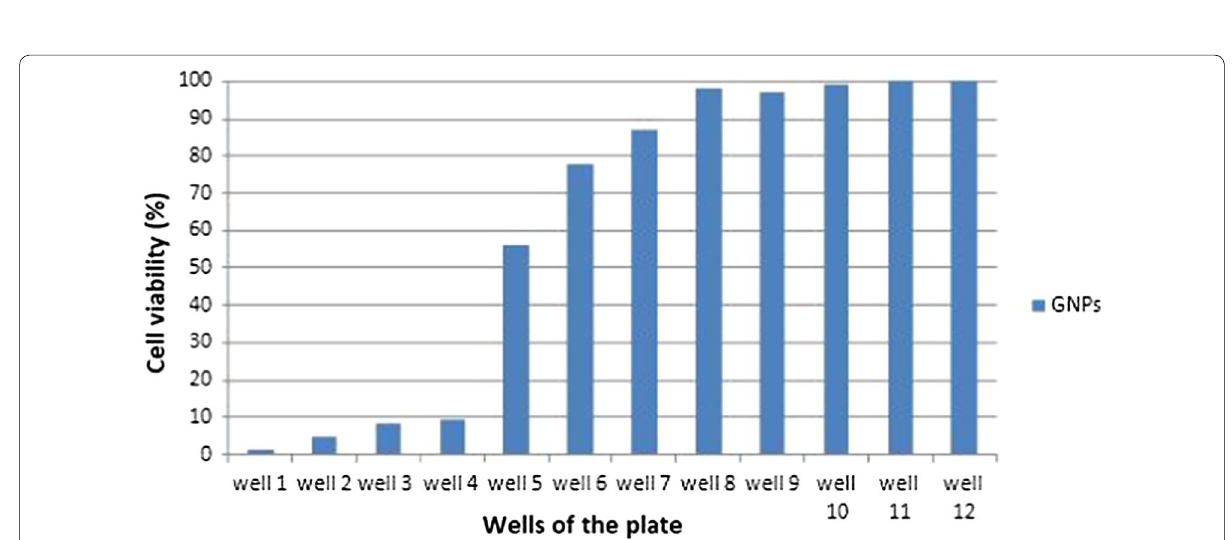
Fig. 5 The cell viability percentages obtained from the MTT test. Well 1 contained the maximum and well 11 contained the minimum concentrations of GNPs. Well 12 was the control and had the maximum cell